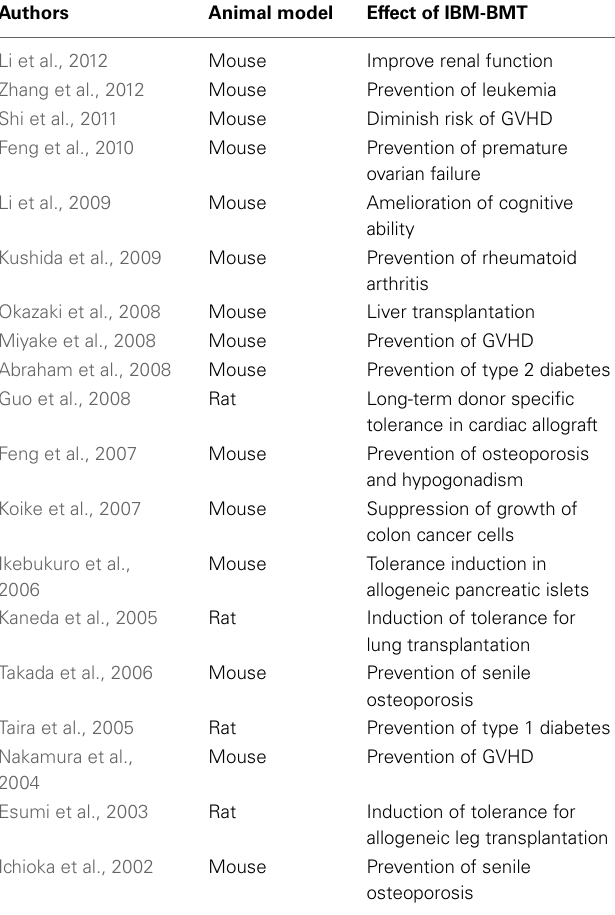
Table 1 | IBM-BMT treatment of various diseases and induction of tolerance for organ